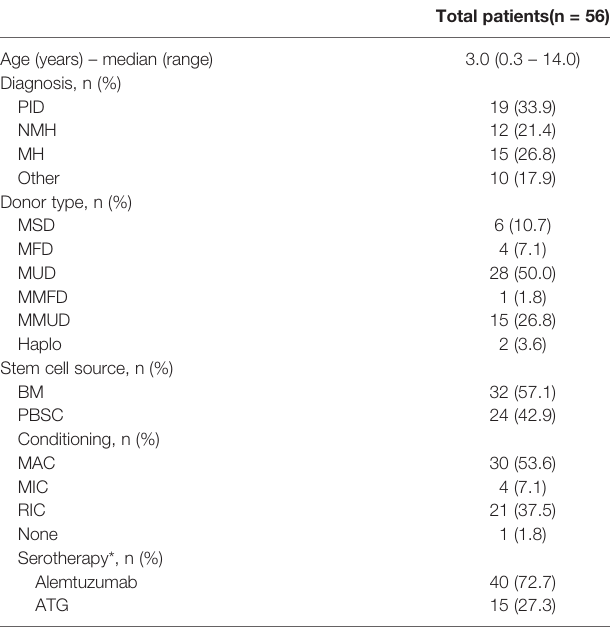
Total patients(n = 56)